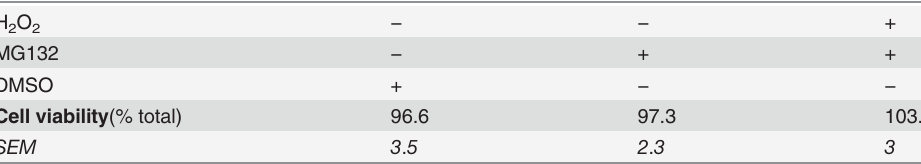
Table 3. Effect of MG132 on cell